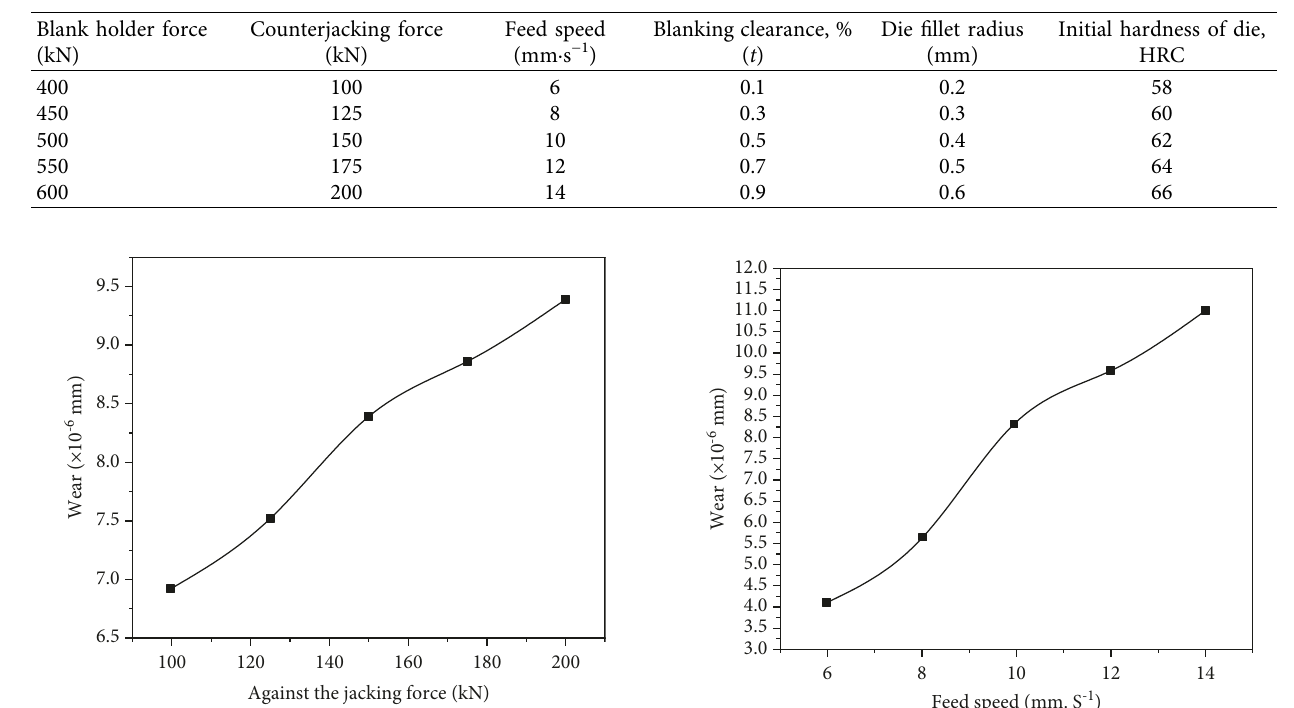
Table 3: Model process parameters and numerical settings.